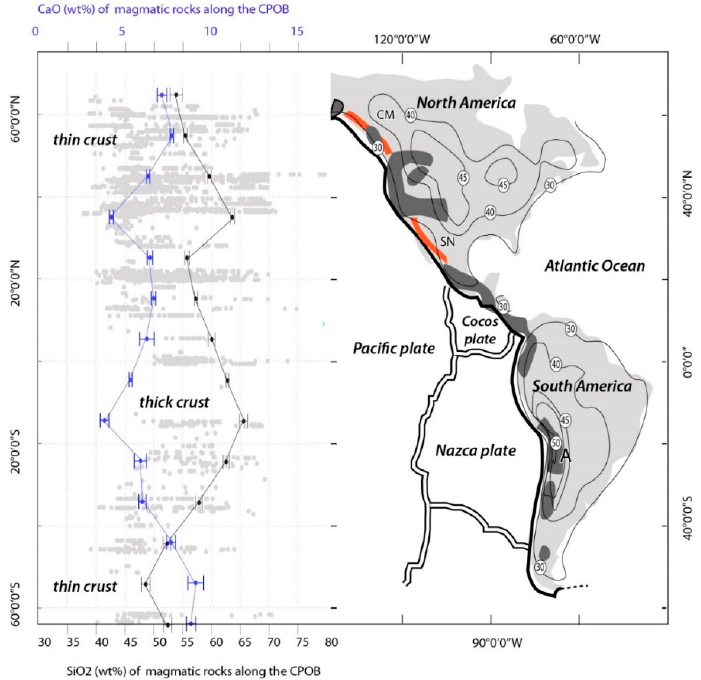
Figure 10. Chemical record (SiO 2 and CaO wt %) of magmatic rocks plotted against the geographic position of Cenozoic-aged samples (ca. 10–0 Ma) along the eastern parts of the circum-pacific orogenic belts (>6850 analyses). Mafic rocks (SiO 2 -poor and CaO-rich) are less abundant in Peru-North Chile magmatic systems, which were developed on a thick continental crust (60 km in the Altiplano area: A) and more abundant along the Northern American Cordilleras (Coast Mountains: CM; Sierra Nevada: SN) and South Chile-Patagonia magmatic systems where the continental crust is thinnest (<30 km). Four isodepth contours (30, 40, 45 and 50 km) are shown on the map based on the global crustal model (2 × 2 degrees) CRUST 2.0 [9].